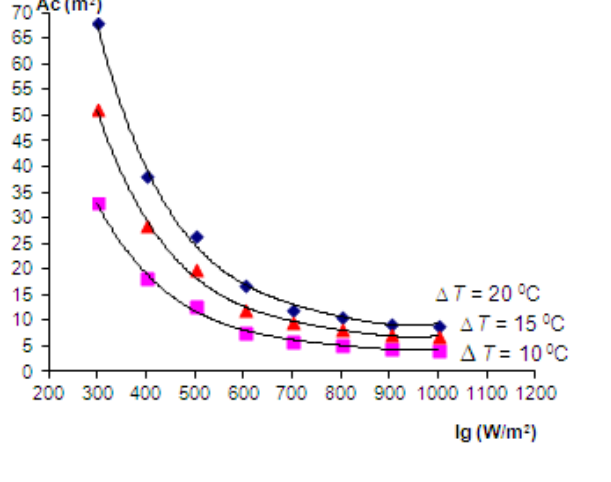
Table 3. Air change per hour ( ACH